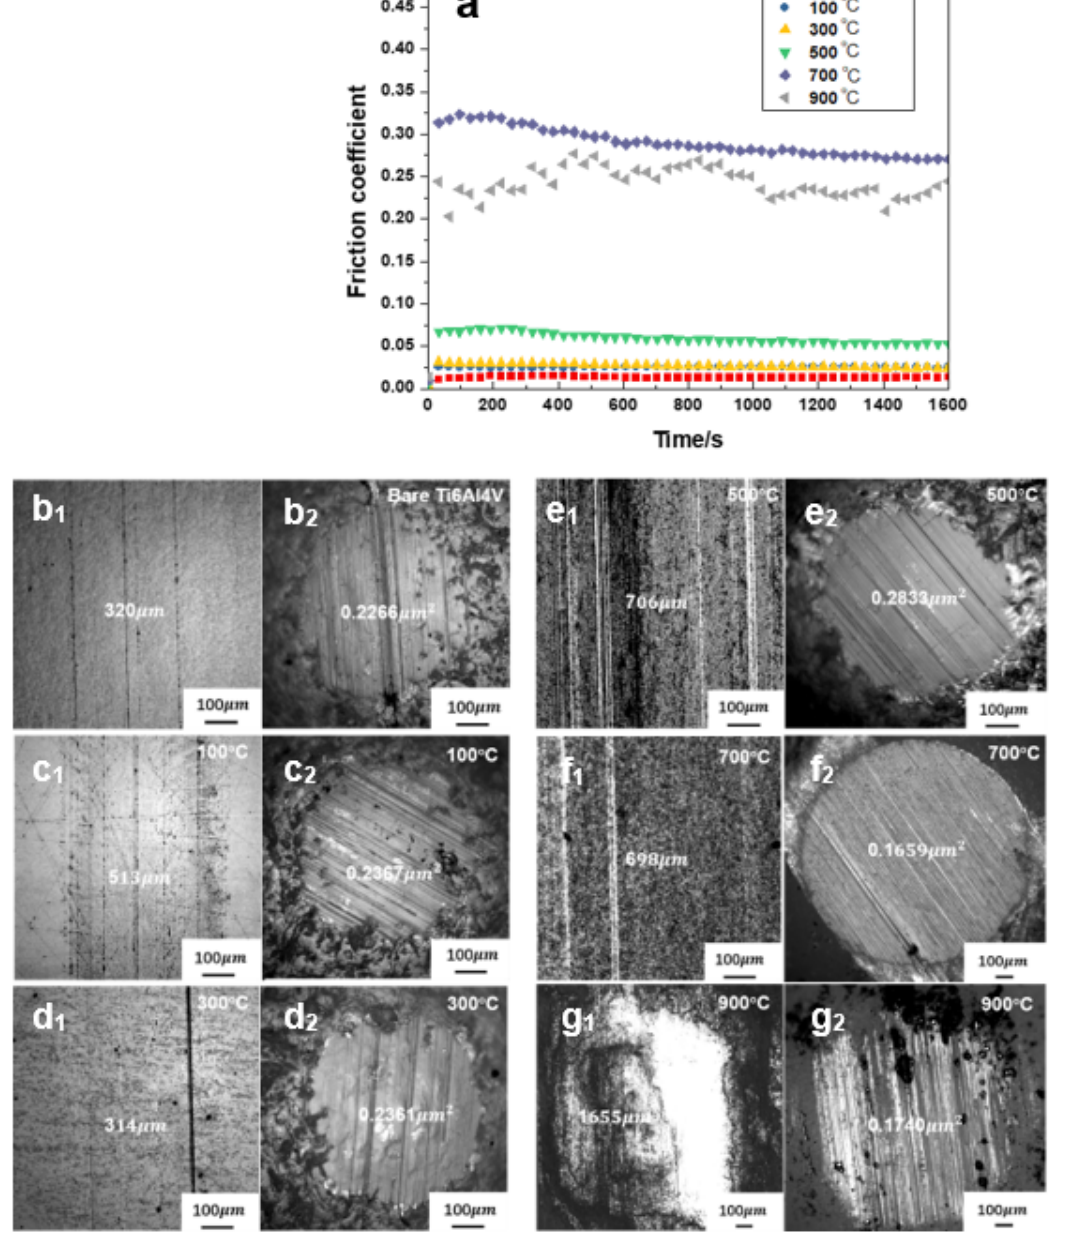
Figure 4. Tribological properties of bare Ti6Al4V and inorganic thermal oxide coatings formed at 100 °C, 300 °C, 500 °C, 700 °C, and 900 °C: ( a ) friction coefficient versus time, ( b 1 – g 1 ) wear morphologies of ( b 1 ) bare Ti6Al4V, ( c 1 – g 1 ) inorganic thermal oxide coatings formed at ( c 1 ) 100 °C, ( d 1 ) 300 °C, ( e 1 ) 500 °C, ( f 1 ) 700 °C, and ( g 1 ) 900 °C, ( b 2 – g 2 ) wear morphologies of PTFE balls (( b 2 ) tribo-pair of the bare Ti6Al4V, ( c 2 – g 2 ) tribo pairs of inorganic thermal oxide coatings formed at ( c 2 ) 100 °C, ( d 2 ) 300 °C, ( e 2 ) 500 °C, ( f 2 ) 700 °C, and ( g 2 ) 900 °C).